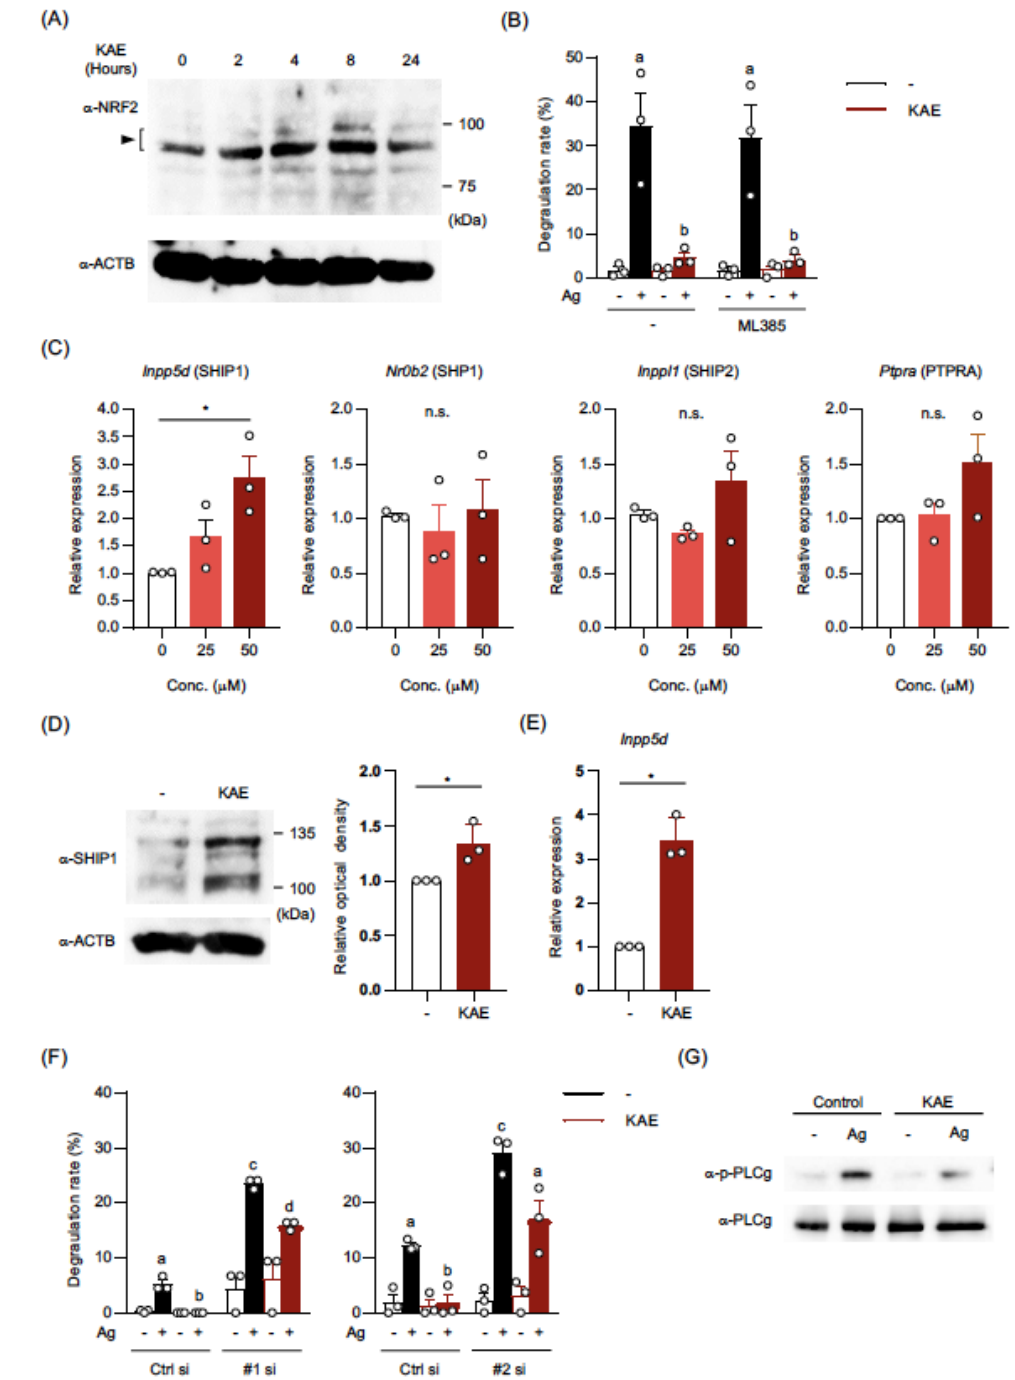
Figure 4. Effects of kaempferol on the NRF2 pathway and the expression of phosphatases in BMMCs. ( A ) Western blot analysis of NRF2. BMMCs were incubated in the presence of KAE (50 μM) and harvested at indicated time. Whole cell lysate containing 10 µ g protein was added to each lane. The expected molecular weight of NRF2 was 97–100 kDa. ( B ) Effects of the NRF2 inhibitor on the suppression of IgE-mediated degranulation of BMMCs by KAE. BMMCs were incubated in the presence of the NRF2 inhibitor, ML385 (5 μM), and KAE (50 μM) for 24 h. Then, BMMCs were sensitized with anti-TNP-IgE and incubated in Tyrode’s buffer with or without TNP-BSA. The su- pernatant was collected for β-hexosaminidase assay. ( C ) mRNA expression levels of SHIP1 ( Inppd5 ), SHP1 ( Nr0b2 ), SHIP2 ( Inppl1 ), and PTPRA ( Ptpra ). BMMCs pretreated with KAE for 24 h were har- vested to assess mRNA levels by qPCR (normalized by β-actin). ( D ) Western blot analysis of SHIP1 protein. BMMCs treated with 50 μM KAE for 24 h were analyzed. Whole cell lysate containing 10 g protein was added to each lane. Data of three independent experiments were quantified by cal- culating the band intensity, and shown as ratio to that of (anti-SHIP1)/(anti-β-actin) in control BMMCs. ( E ) mRNA expression levels of SHIP1 ( Inppd5 ) in peritoneal MCs. Peritoneal MCs pre- treated with KAE for 24 h were harvested to assess mRNA levels by qPCR (normalized by β-actin). ( F ) The effects of SHIP1 knockdown on the degranulation of BMMCs. BMMCs were transfected with